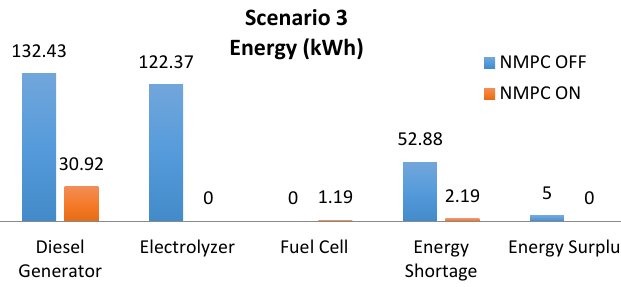
Figure 23. Comparative results in energy management in seven-day operation.